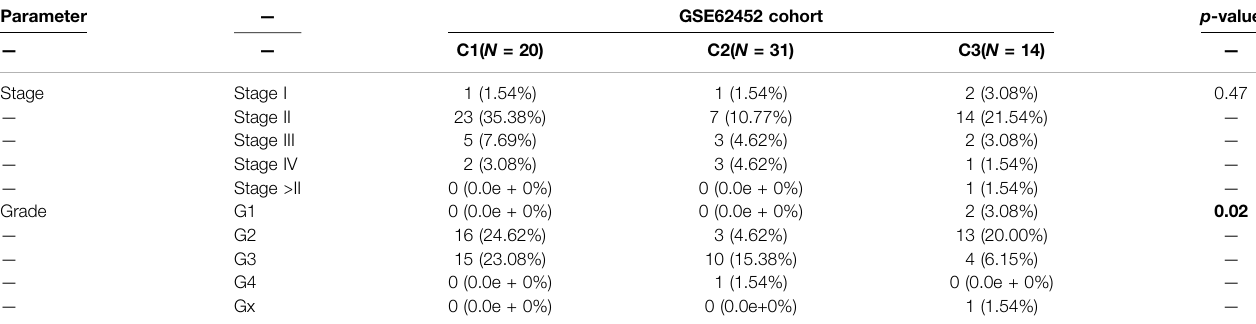
TABLE 2 | Correlation of C1, C2, and C3 subtypes of clinicopathological features in patients with PDAC from GSE62452 cohort.